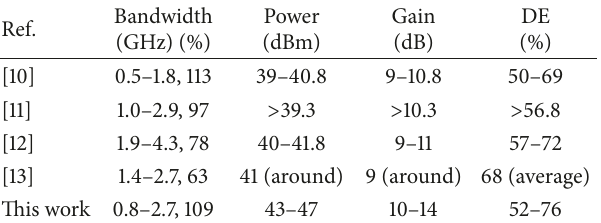
Table 1: Comparison with the state-of-the-art broadband power amplifiers.